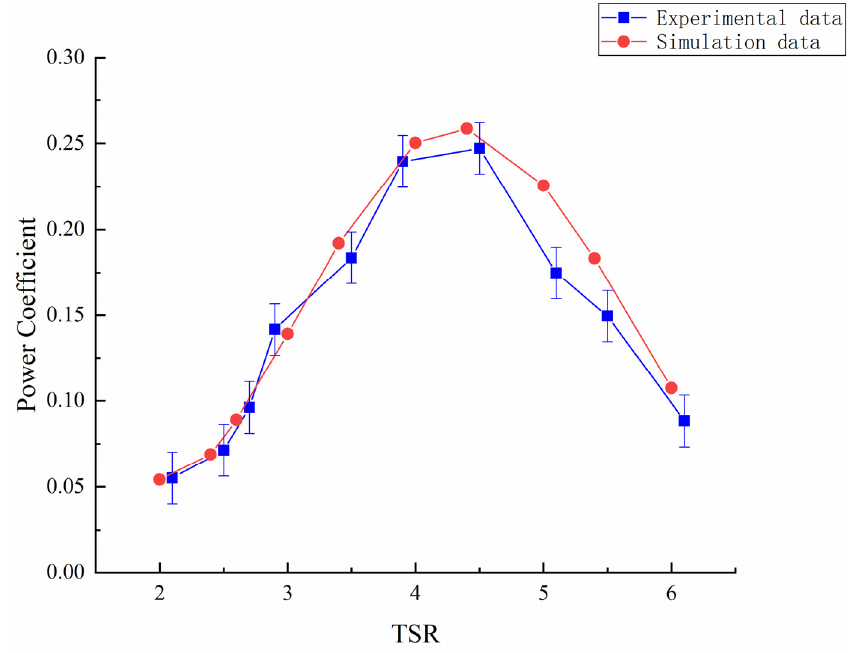
Figure 14. Comparison of experimental data and simulation data of power coefficient.